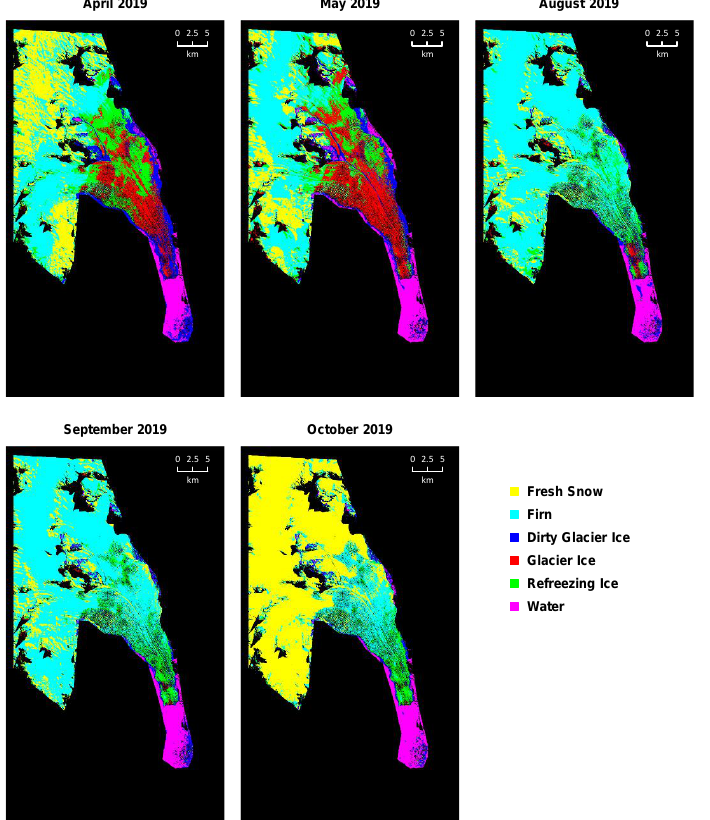
Figure 8. Classification results achieved for the whole area of the Tyndall Glacier for the months of April, May, August, September and October of the year 2019. Note that all possible shadow extents are excluded by one mask applied to all investigated